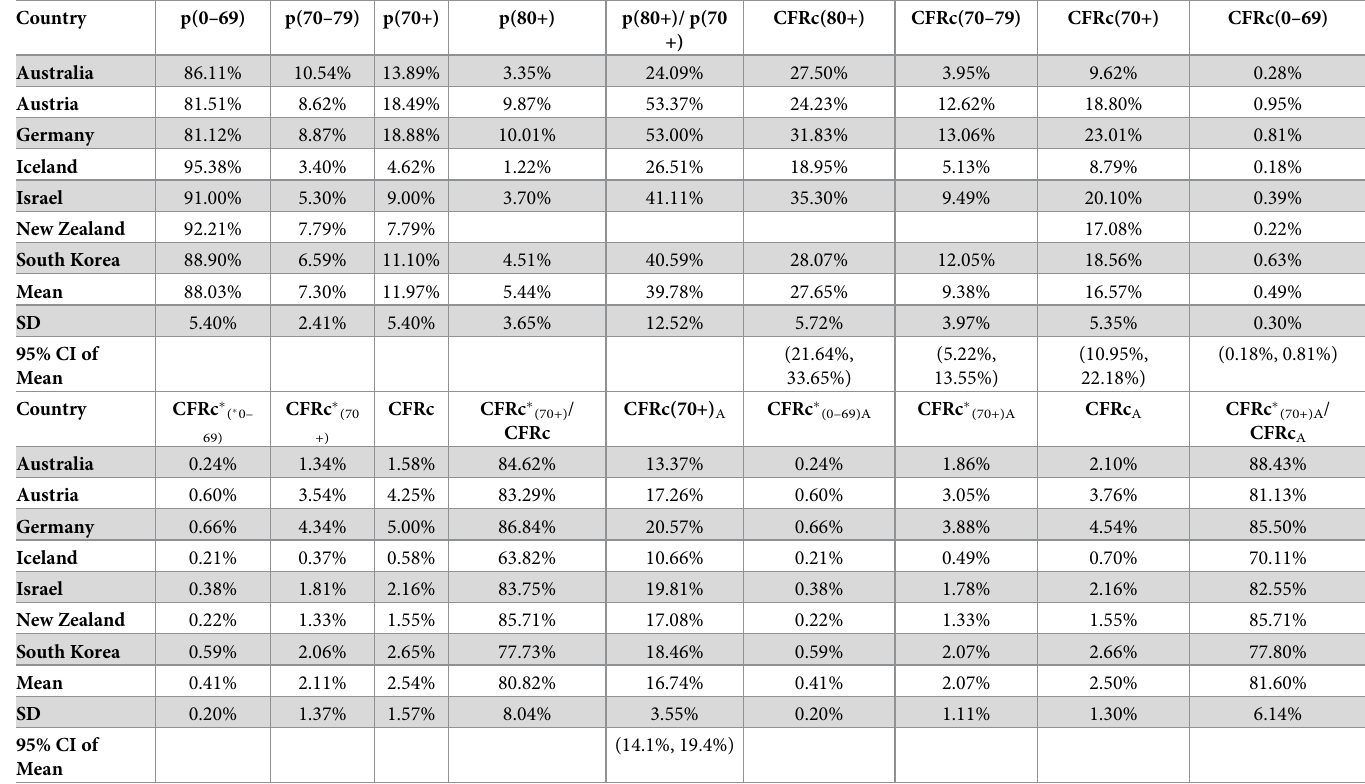
Table 3. Age specific fractions of cases, age specific corrected CFR, and contributions of each age group to the overall corrected CFR for each country.